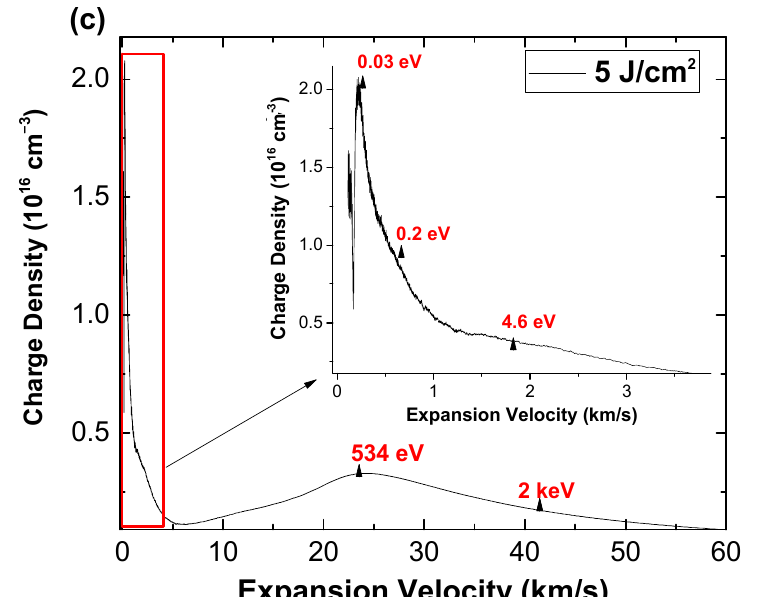
0.85 × 10 18 cm − 3 to 1.25 × 10 18 cm − 3 for HfO 2 , and from 0.6 × 10 18 to 2 × 10 18 cm − 3 for the ZrO 2 , with the Debye length decreasing in the 0.20–0.18 µ m range. The representation of the Hf charge density as a function of laser fluence sees an increase of a factor of 3 up to a maximum of 7.2 × 10 15 cm − 3 at 0.9 J/cm 2 , followed by a decrease, which coincides with the appearance of the O charge peak, which increases quasi exponentially from 3 × 10 15 cm −